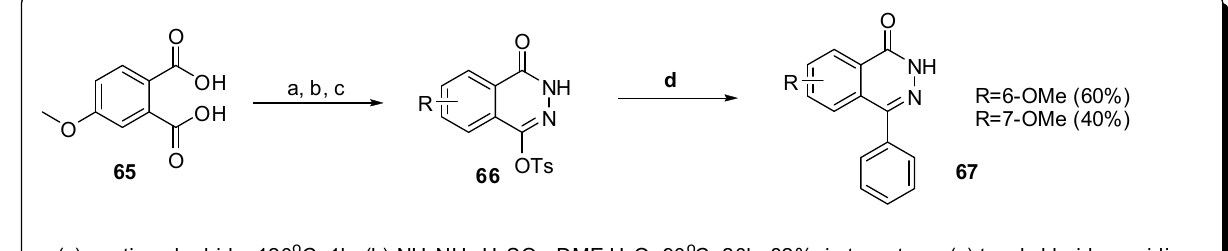
Figure 21. Use of MAOS to construct phthalazinone scaffold.